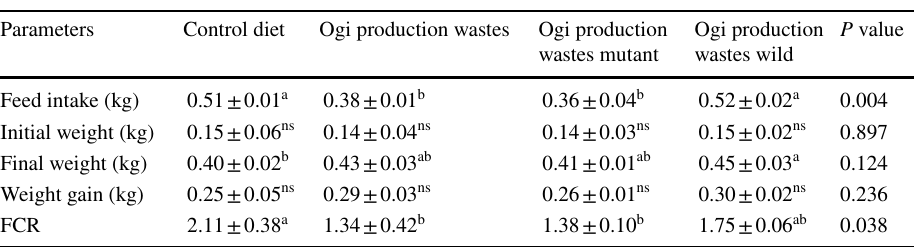
Values are mean ± standard deviation, mean with different superscripts within the same row are signifi- cantly ( P < 0.05) different ns non-significant, FCR feed conversion